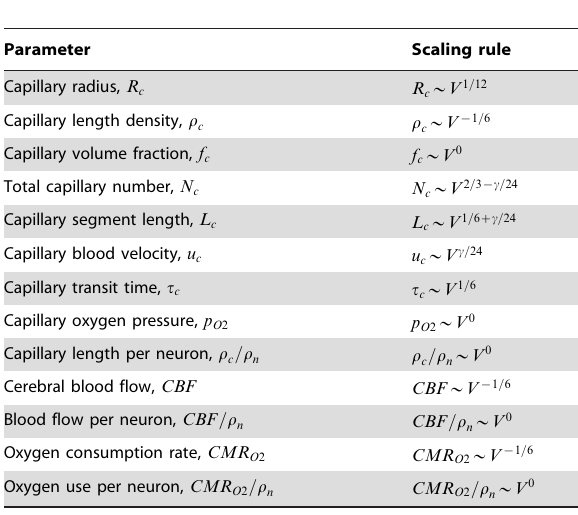
Table 3. Summary of scalings for brain capillaries and hemodynamics against cortical gray matter volume V .